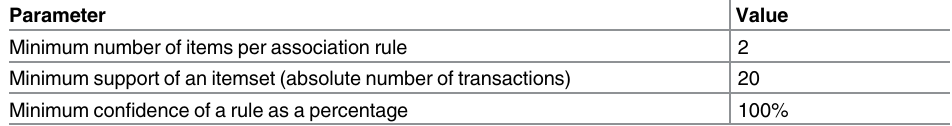
Table 4. Apriori threshold values considered for the